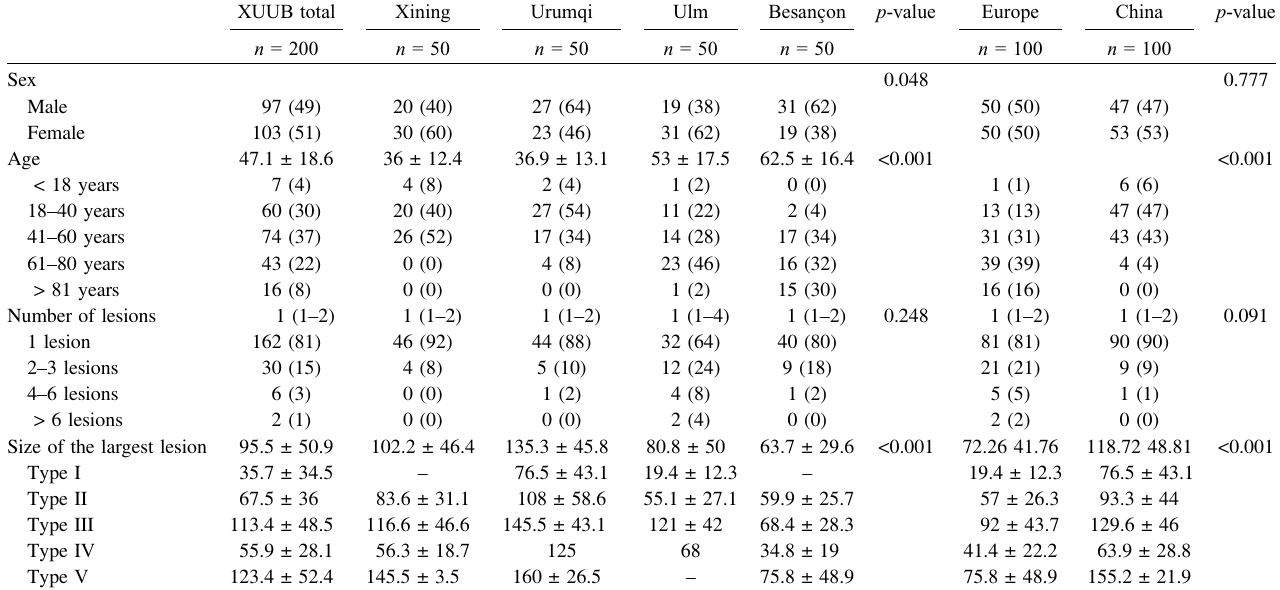
Table 1. Characteristics of the study